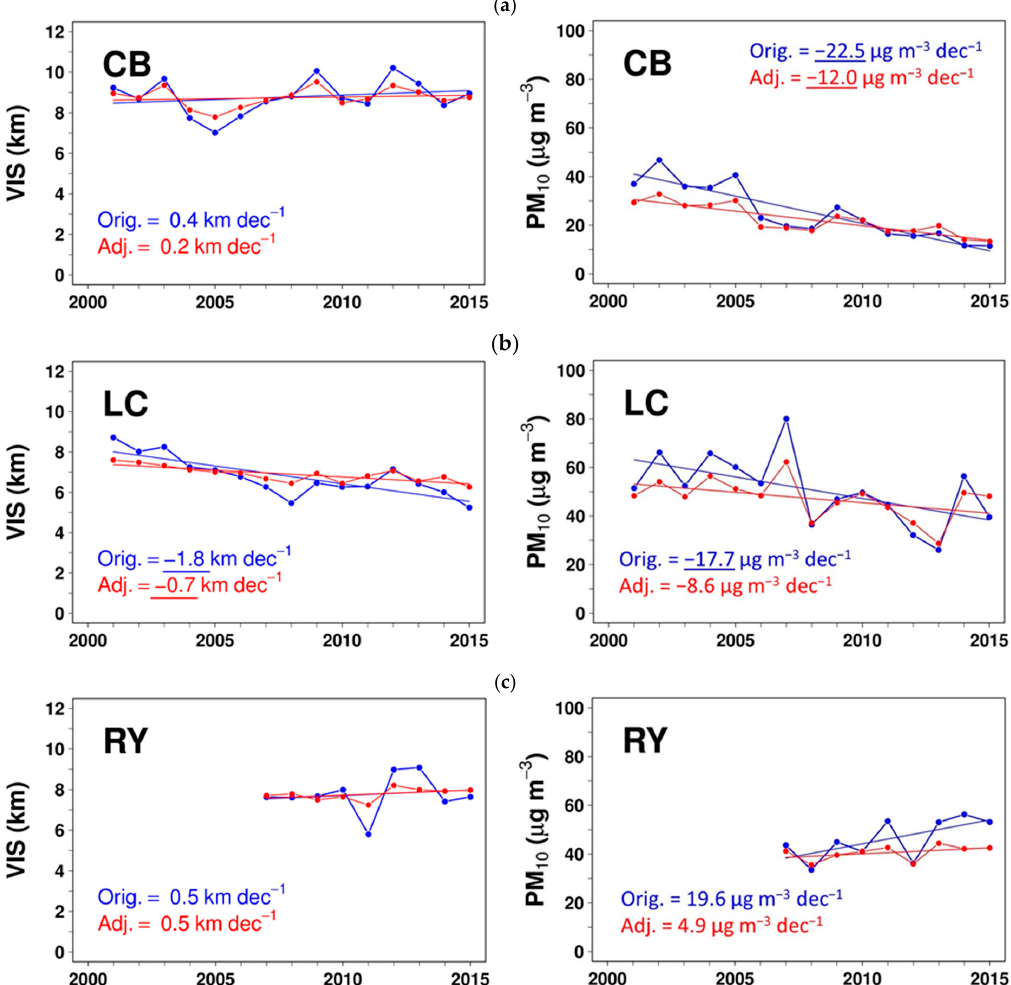
Figure 10. Meteorologically adjusted (red) and original or non-adjusted (blue) trends in visibility and PM 10 at ( a ) Chon Buri (CB); ( b ) Laem Chabang (LC); ( c ) Rayong (RY). The underlined values are of statistical significance at a 0.05 level against the null hypothesis of no trend. At each station, the trend period was determined by the time coverage of the visibility and air quality data available and